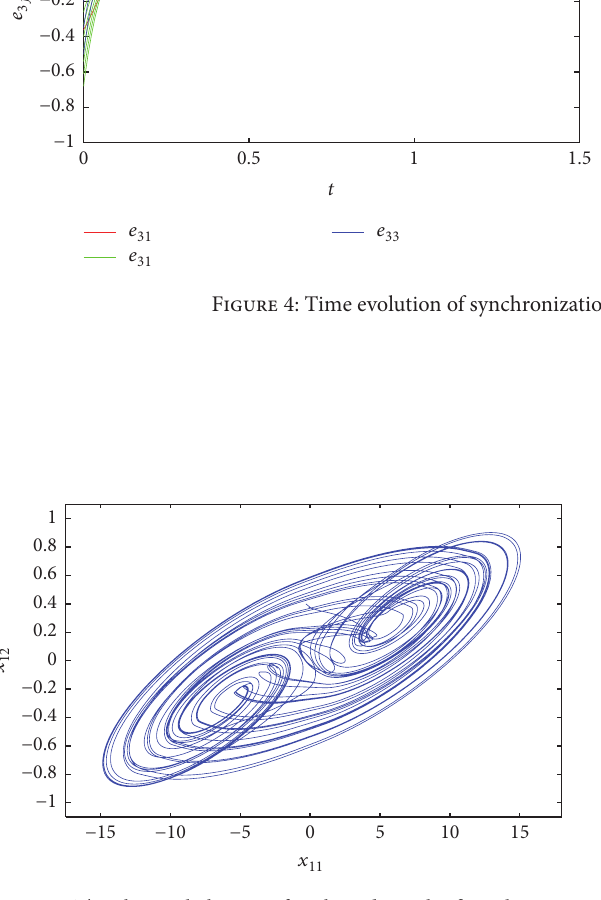
Figure 5: The chaotic behavior of each node in the first cluster in